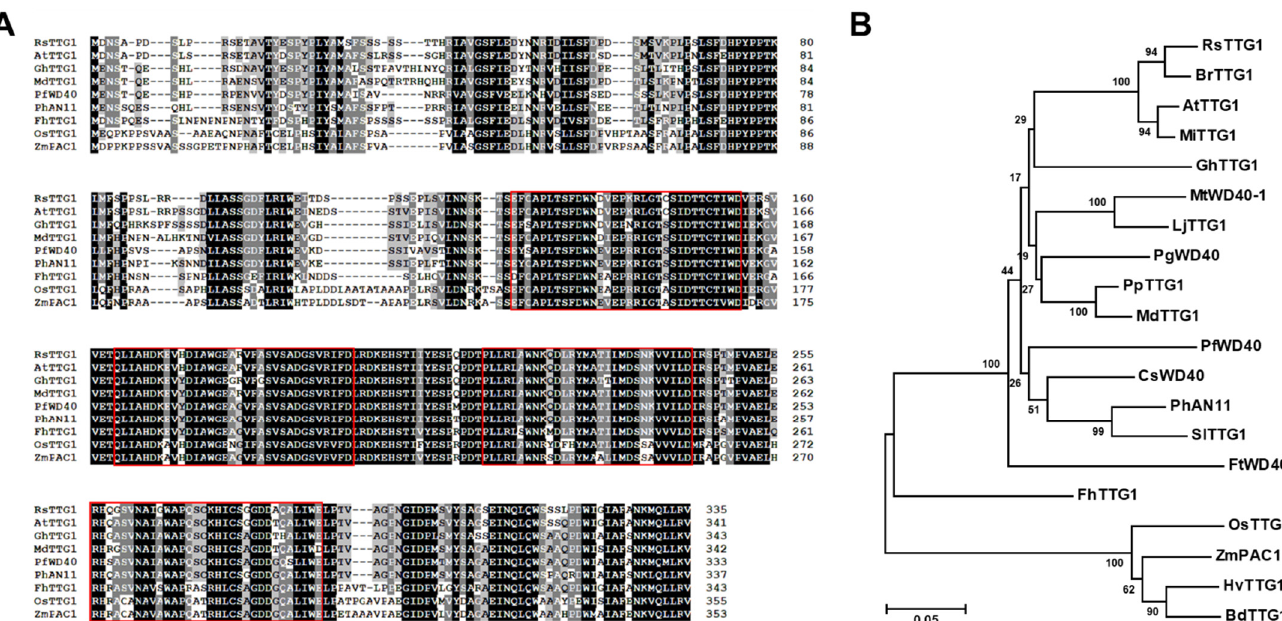
Figure 1. Phylogenetic relationships of RsTTG1 and selected WD40 proteins from other plant species. ( A ) Sequence alignment of RsTTG1 and its closest homologs, which are known to regulate flavonoid biosynthesis. Absolutely conserved residues are highlighted in black, while partially conserved residues are shown in gray. The positions of the WD repeats are shown in the red boxes. ( B ) Phylogenetic tree of RsTTG1 and related WD40 proteins from other plants. The phylogenetic tree was constructed using the neighbor-joining method with MEGA6 software. The GenBank accession numbers of the WD40 protein sequences are as follows: Arabidopsis thaliana AtTTG1 (Q9XGN1);